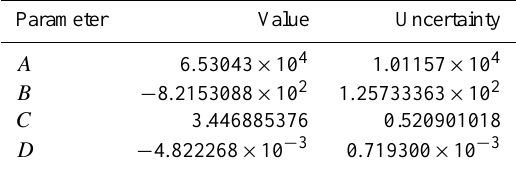
Table 5. Parameters A , B , C , and D for the parameterisation of n s (T ) or k(T ) for the immersion freezing of water droplets con- taining illite in the low surface area